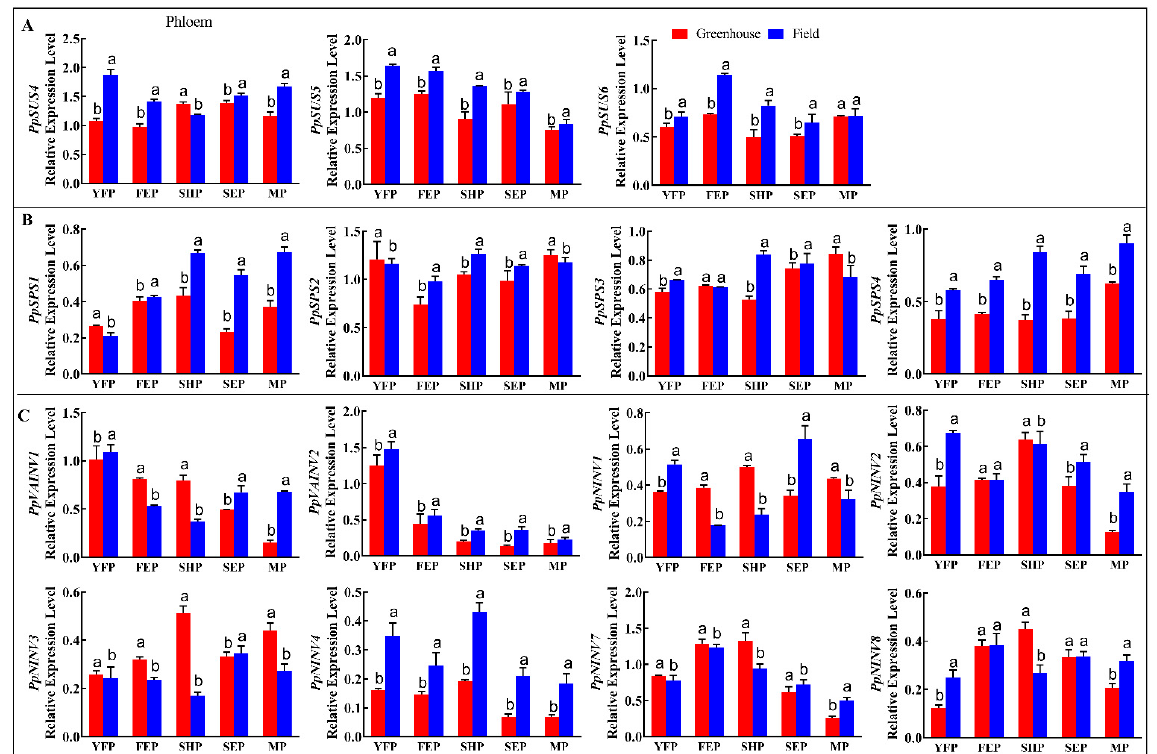
Figure 9. Expression levels of sucrose metabolism-related genes in the phloem of plants grown in field and greenhouse environments. ( A – C ) show the expression levels of SUS, SPS and INV-related genes, respectively. The data are presented as the means ± SDs from three biological replicates. Different lowercase letters indicate significant differences ( p < 0.05).